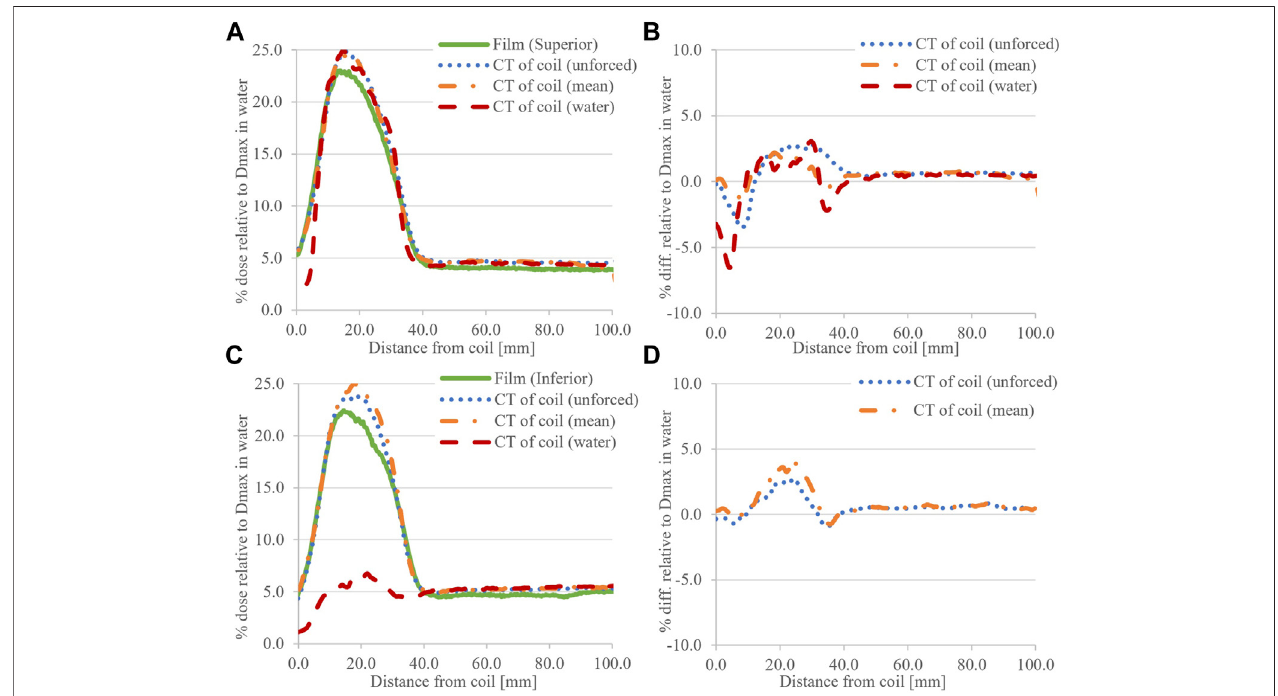
FIGURE 9 | Calculated ESE dose for the 8.0 × 22.0 cm 2 fi eld with a CT of the coil, compared to fi lm data. (A) shows the superior (+Y) data with (B) associated difference plots. Similarly for (C) inferior ( − Y) and (D) associated difference plots. The RED status of the coil is provided in parentheses, and the omission of the inferior differences was noted when this was set to 1.000 (water) due to its obvious mismatch with